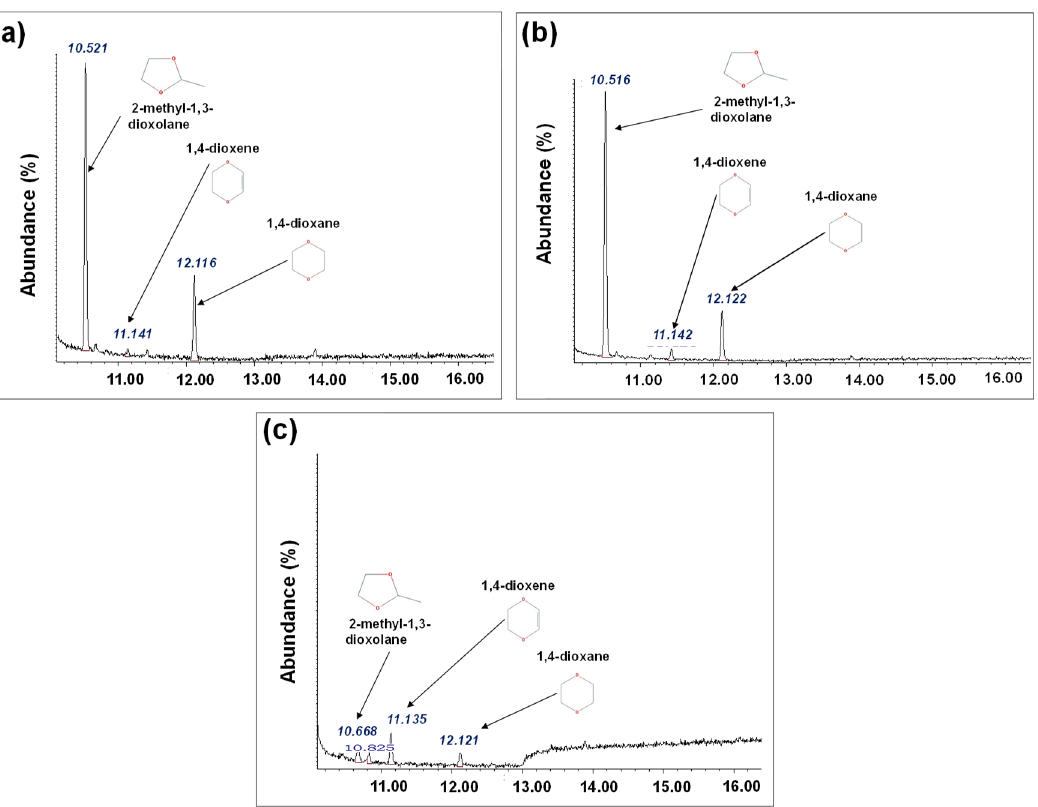
Figure 5. Time-series GC/MS of the wastewater from the textile industry. ( a ) raw wastewater, ( b ) effluent of CSTR, and ( c ) effluent of PFR .